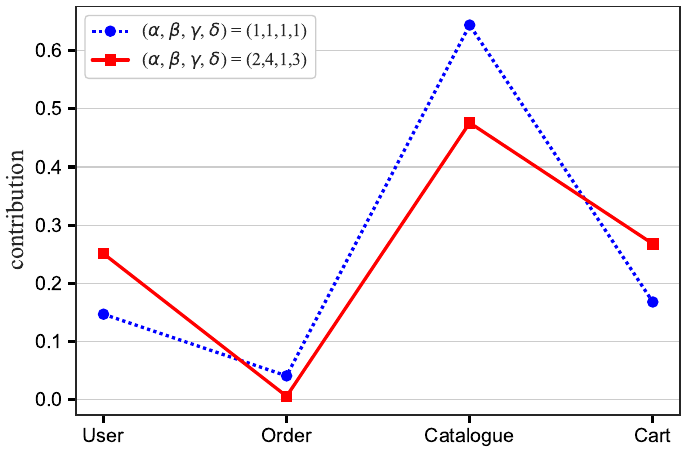
Figure 10. The database contributions to business scenarios in Sock-Shop .